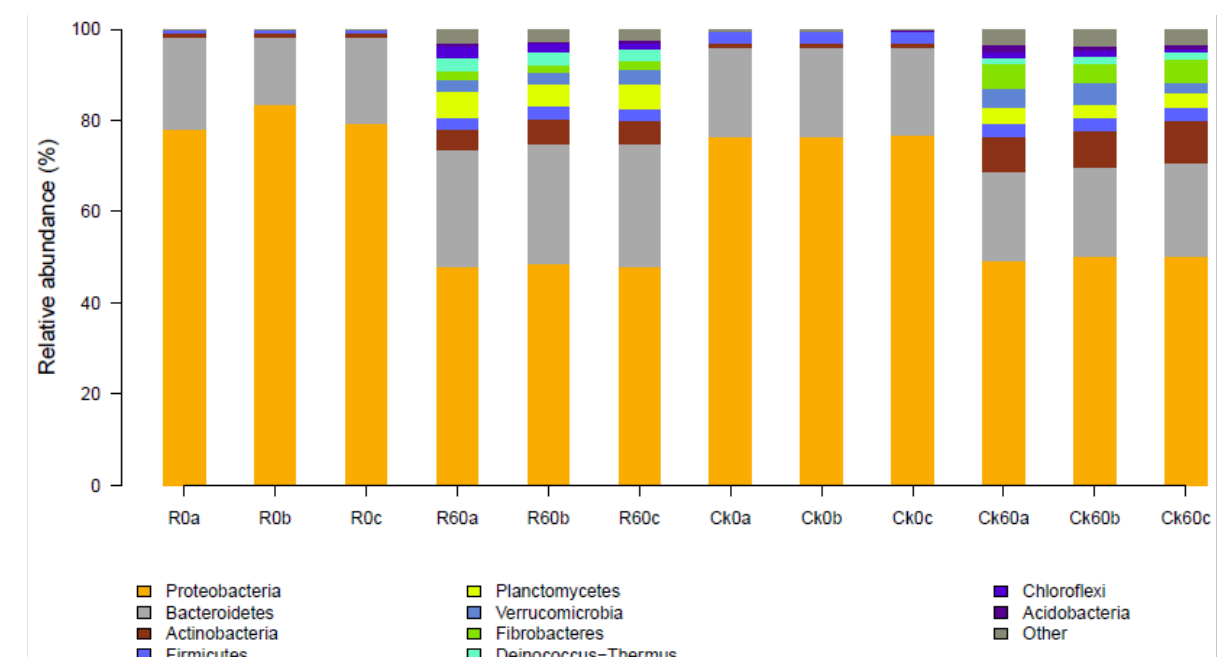
Figure 5. Composition of the bacterial communities at the phylum level. R 0a , R 0b , and R 0c : samples of the rice straw inoculated with earthworms, R 60a , R 60b , and R 60c : samples of the rice straw inoculated with earthworms after 60 days. CK 0a , CK 0b , and CK 0c : samples of the rice straw without earthworms. CK 60a , CK 60b , and CK 60c samples of the rice straw without earthworms after 60 days.